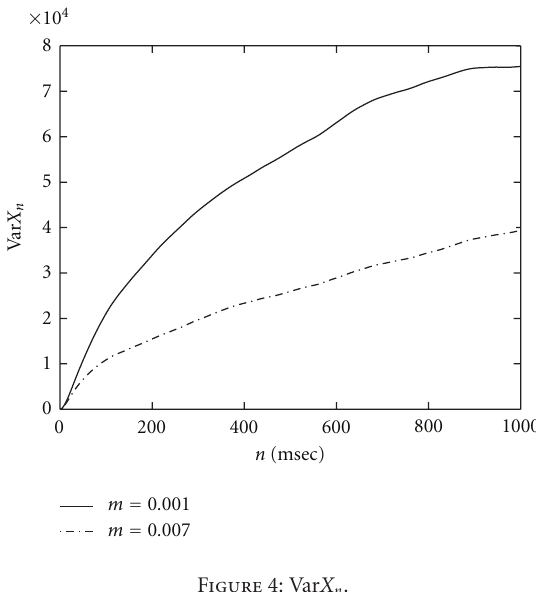
Figure 4: Var X n